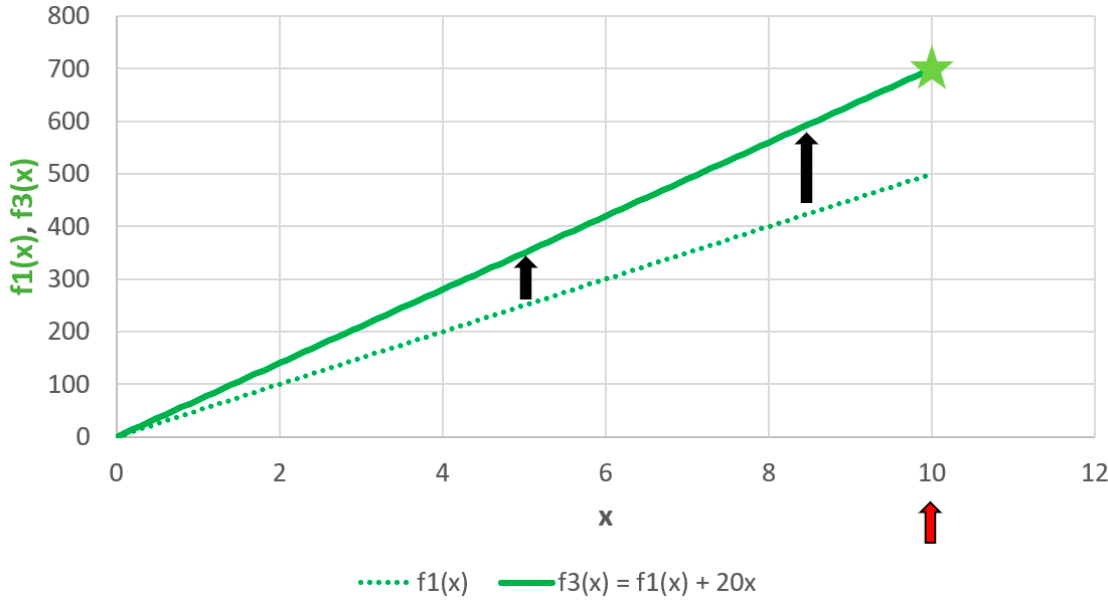
Figure 6. The value per area unit of the free GREEN territory increases, by 40%.